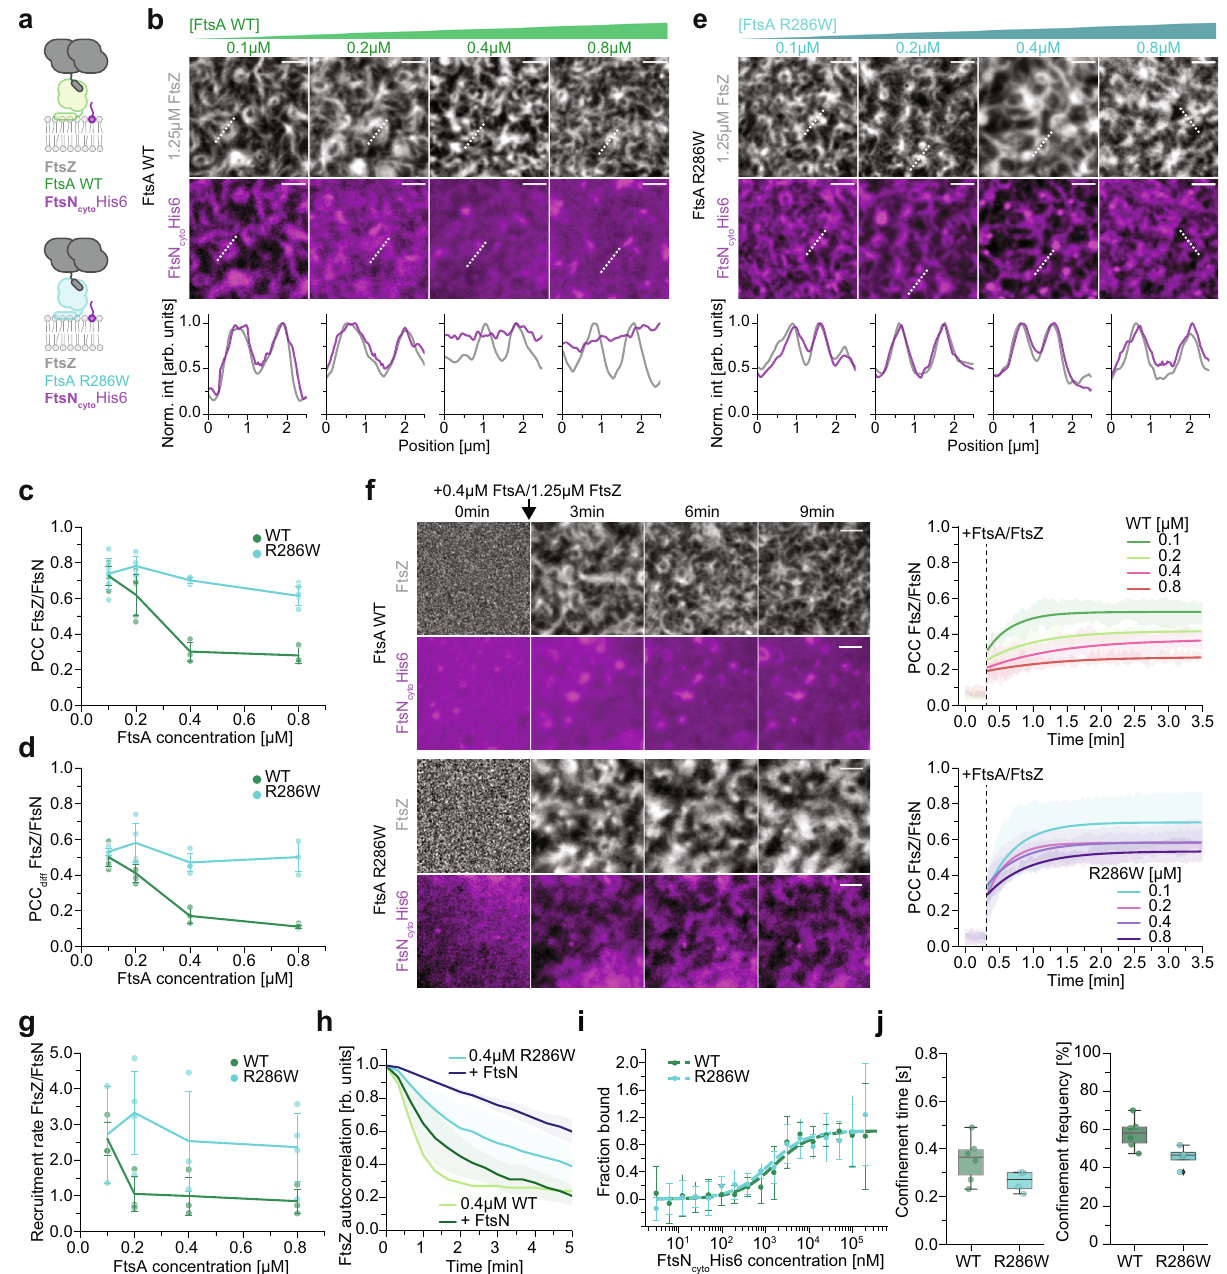
Fig. 2 FtsA R286W shows enhanced recruitment of FtsN cyto to FtsZ fi laments. a Schematic illustrating added components and fl uorescently labelled proteins (bold) in experiments shown in b and e . b Representative micrographs of Alexa488-FtsZ (grey) and Cy5-FtsN cyto (magenta) at increasing FtsA WT and constant FtsZ concentrations. Intensity pro fi les correspond to the dashed white lines. c Colocalization of FtsZ and FtsN cyto in the presence of FtsA WT (green) or FtsA R286W (cyan) quanti fi ed by PCC. n (WT) = 5/5/3/3 and n (R286W) = 6/4/4/5. d Dynamic colocalization of FtsZ and FtsN cyto in the presence of FtsA WT (green) or FtsA R286W (cyan) quanti fi ed by PCC diff . n (WT) = 5/5/3/3 and n (R286W); = 4/4/4/3. e Representative micrographs of Alexa488-FtsZ (grey) and Cy5-FtsN cyto (magenta) at increasing FtsA R286W and constant FtsZ concentration. Line pro fi les were taken along dashed white lines. f Top: Cy5-FtsN cyto (magenta) is not enriched on FtsZ fi laments after adding Alexa488-FtsZ (grey) and 0.4 µ M FtsA WT at 0 min. Bottom: In experiments with 0.4 µ M FtsA R286W, Cy5-FtsN cyto colocalizes well with FtsZ fi laments. Right: Increase of PCC after addition of FtsZ and different FtsA WT (top) or R286W (bottom) concentrations. Thick lines depict power law exponential fi ts towards the mean PCC, shaded area is the standard deviation. g Quanti fi cation of the recruitment rate of FtsN cyto towards FtsZ fi laments, extracted from experiments in f by fi tting a power law exponential to individual experiments. n (WT) = 3/3/3/3 and n (R286W) = 2/4/3/4. h FtsN cyto increases the persistency of the FtsZ network with both, FtsA WT and R286W. n (WT/R286W) = 3. i Quanti fi cation of the binding af fi nity of FtsN n (WT, R286W) = 3. j Quanti fi cation of the cyto towards FtsA WT or R286W by MST. duration and frequency of FtsN cyto single molecule con fi nement events. n (WT/R286W) = 6/4.Scale bars are 2 µ m. Dots in all plots represent independent experiments, thick lines indicate the mean and error bars or shaded areas depict the standard deviation. The boxes indicate the 25 – 75th percentiles, whiskers show the maximum/minimum values within the standard deviation, the midline indicates the median and diamonds indicate outliers. Source data are provided as a Source Data fi